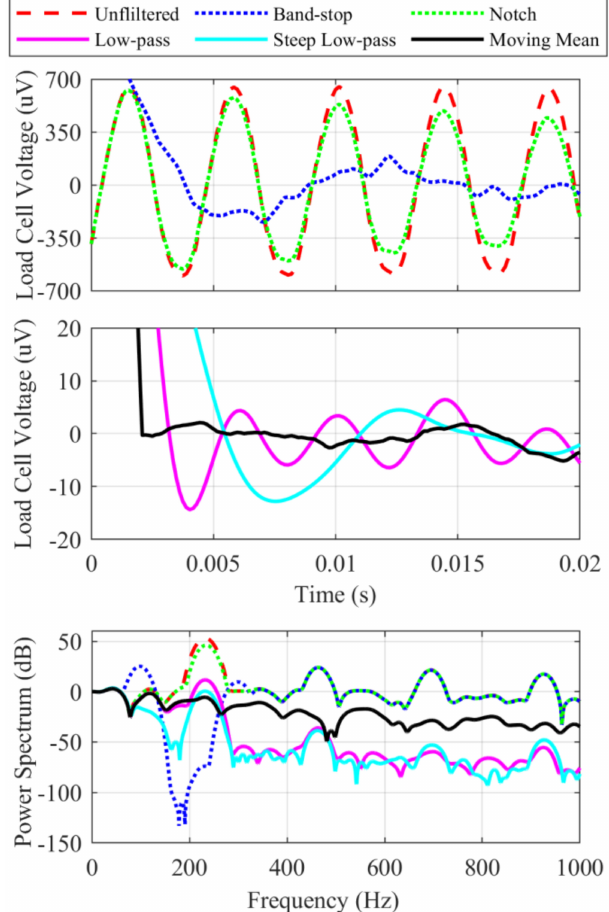
Figure A1. Filters designed to mitigate high-frequency noise. ( Top ) and ( middle ) have the same time scales; however, the low-pass, steep low-pass, and moving mean filters drastically reduce the amplitude of the signal and therefore require a smaller load cell voltage range for their results to be visible. ( Bottom ) The impact of the filters on the power